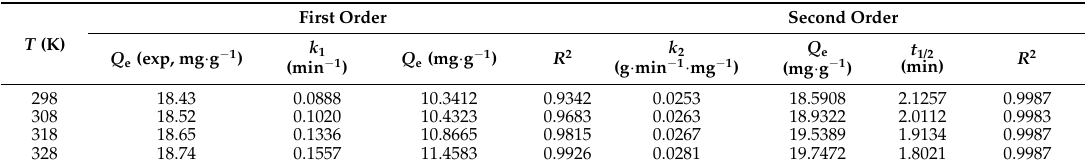
Table 2. Lagergren pseudo first and second order kinetics parameters for iron adsorption by resin Rexp-501.